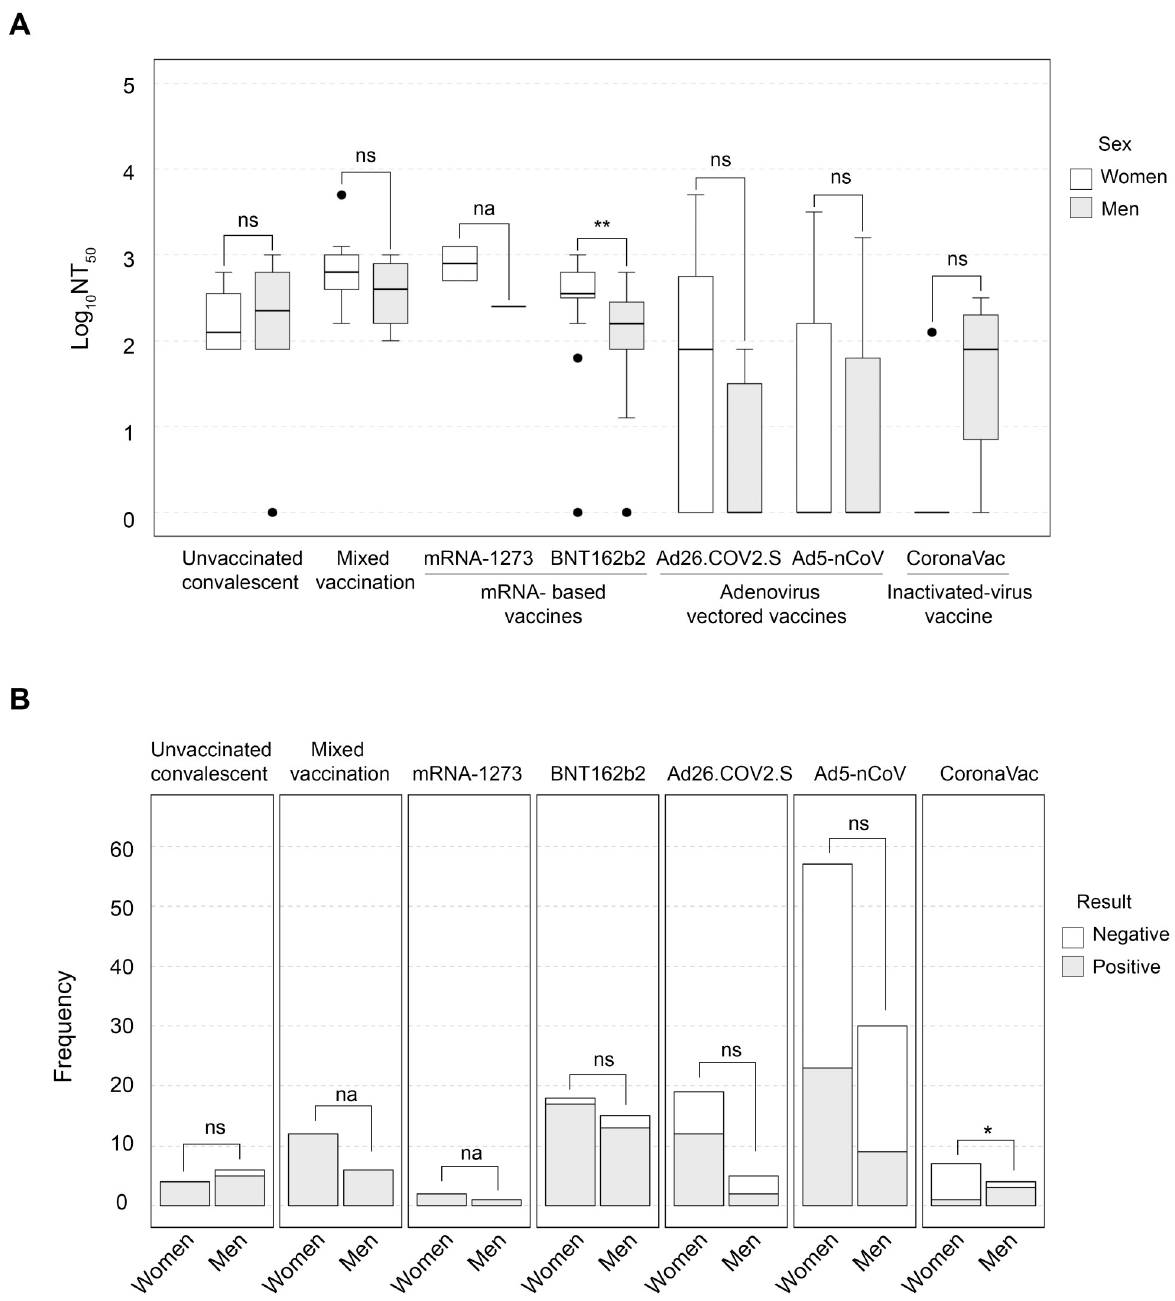
Fig 3. NAb production is similar in women and men among most immunization schemes. A) Box plot showing NAb titers among vaccines grouped by sex. Pairwise comparisons were performed with the Mann-Whitney U test. B) Stacked bars graph showing frequencies in positive and negative results among immunization schemes by sex. Differences between results of women and men were explored by Chi-squared tests. For both panels, na = not applicable for the test, ns = not significant, � = p < 0.05, �� = p < 0.01.